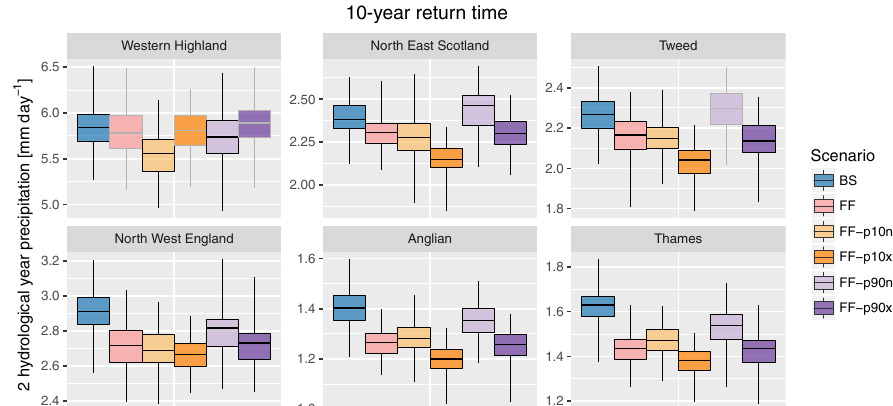
Figure 15. Distribution of return values of the 10-year event for low precipitation on two consecutive hydrological years (box plot) for each region (panel) and scenario (colour). Whiskers display the range from individual time series. Grey boxes for future scenarios indicate statistically non-significant change in mean return value with respect to the baseline at the 95% level according to a two-sided T test. See Fig. S20 for the plots for all regions; the corresponding figure for the near-future time slices is shown in Fig. S21.